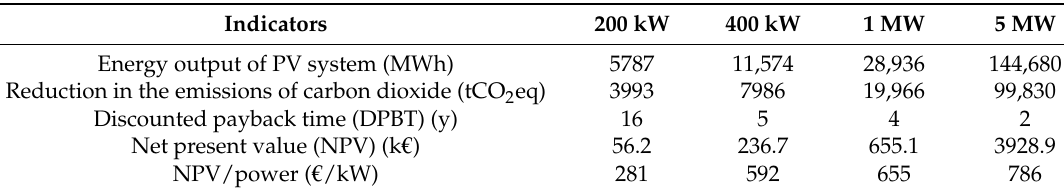
(Table 3): (i) a reduction of pollutant emissions and (ii) the generation of economic opportunities. Table 3. Indicators–baseline